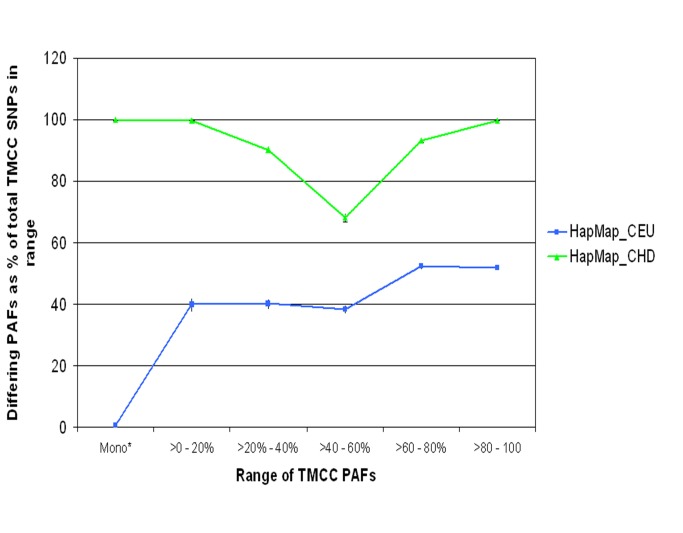
The number of SNPs in each TMCC prevalence range with a statistically significant different PAF than HapMap CEU or CHD MAFs.